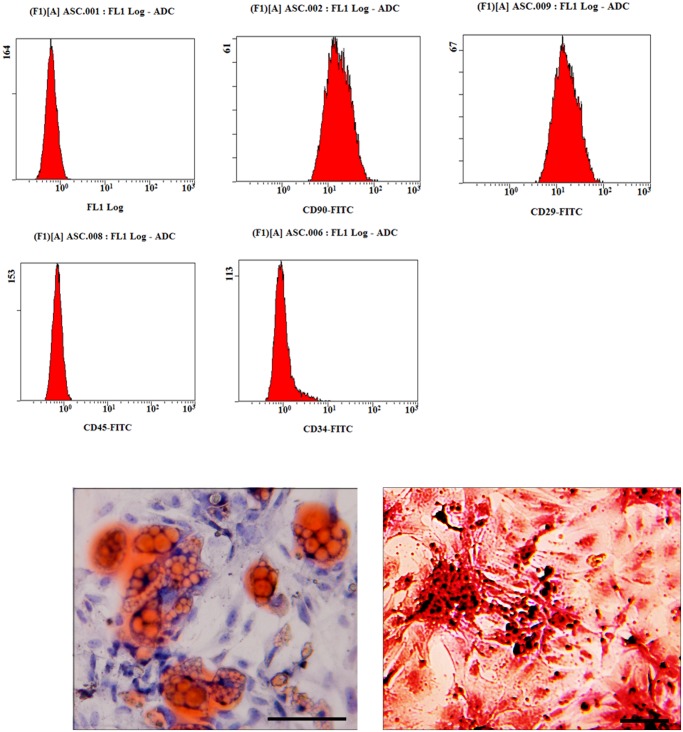
Characterizatio of rat AMSCs.A, flowcytometery demonstrated that most AMSCs express CD90, CD29 and do not express CD45, CD34; Furthermore, no significant difference was found between AMSCs and hypoxia-treated AMSCs; B, After culture in differentiating medium, AMSCs differentiated in to adpogenic and osteogenic lineages and differentiated cells could be positively stained by Oil red O staining and Alizarin red S staining (Scale bar: 50μm).